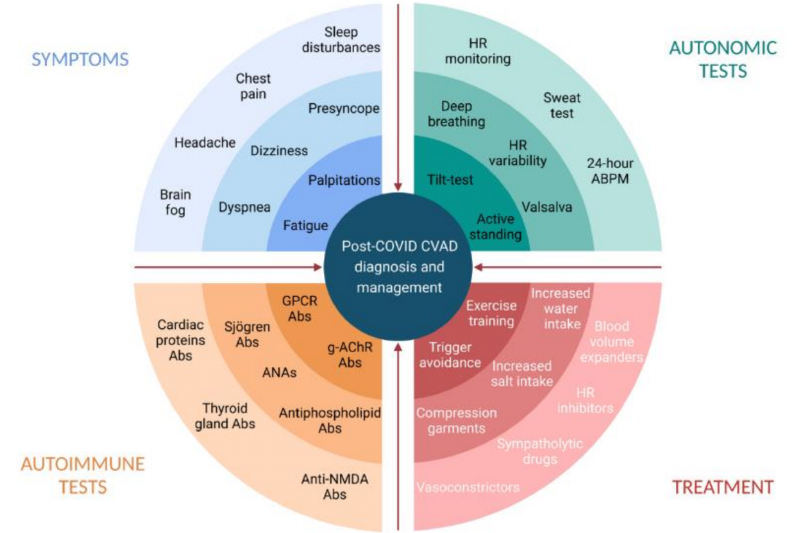
Figure 1. Post-COVID cardiovascular autonomic dysfunction: diagnosis and management. Abs, antibodies; ANAs, antinuclear antibodies; CVAD, cardiovascular autonomic dysfunction; g-AChR, ganglionic neuronal nicotinic acetylcholine receptor; GPCR, G-Protein coupled receptor; HR, heart rate. Created with